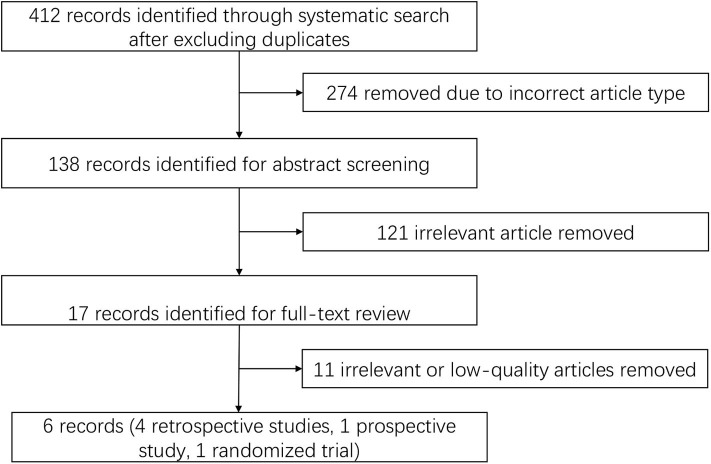
Study selection.